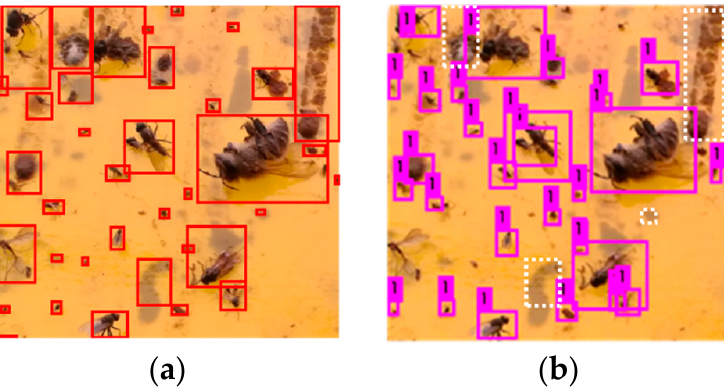
Figure 11. Comparison of detection instances. ( a ) Connected components labeling detection instance; ( b ) YOLO detection instance.